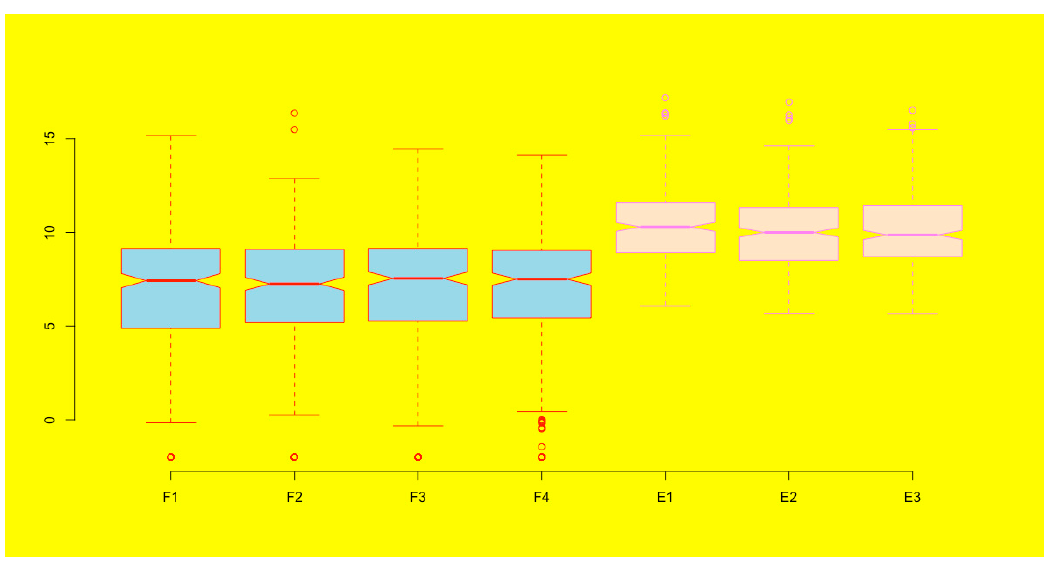
Figure 22. Add background color to a figure.